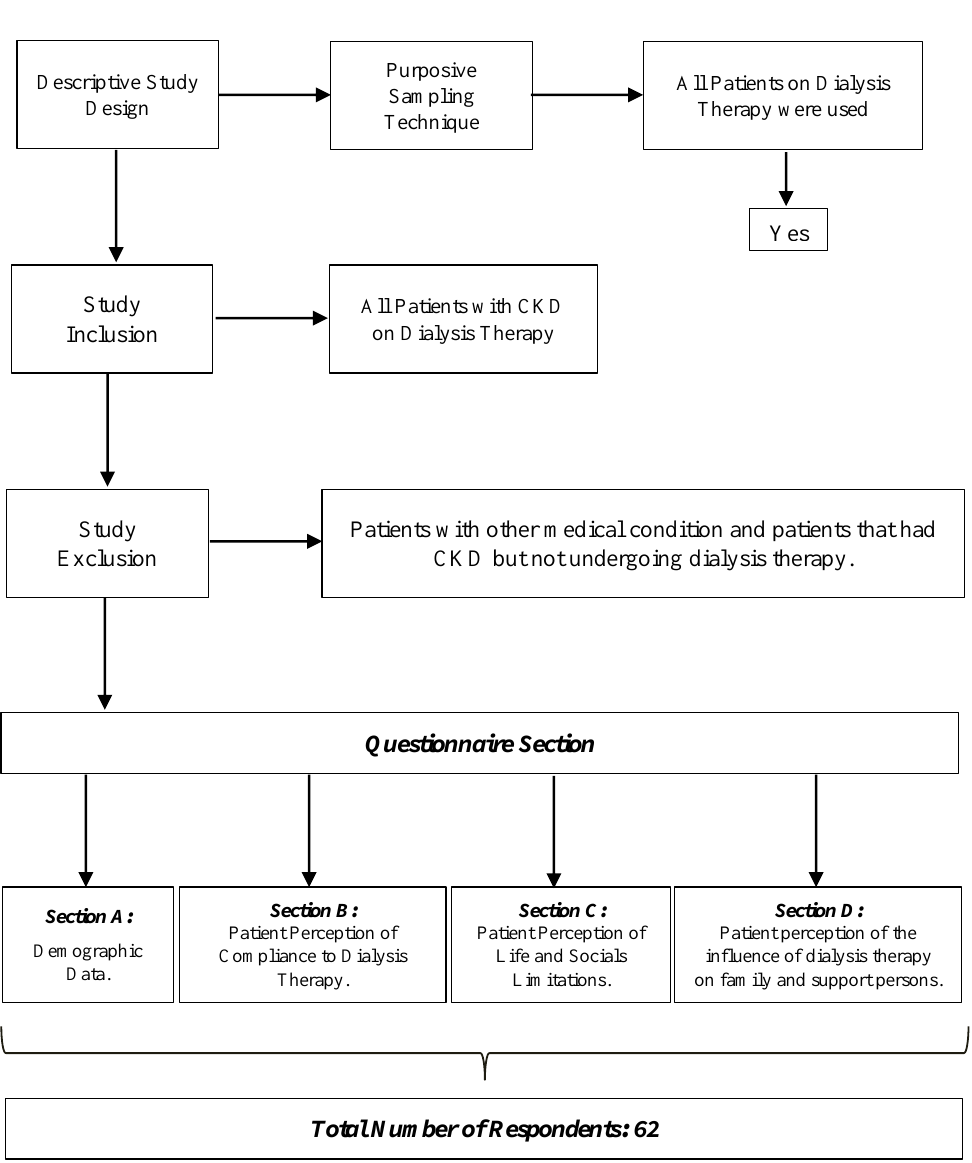
Figure 1. Flowchart illustration on research